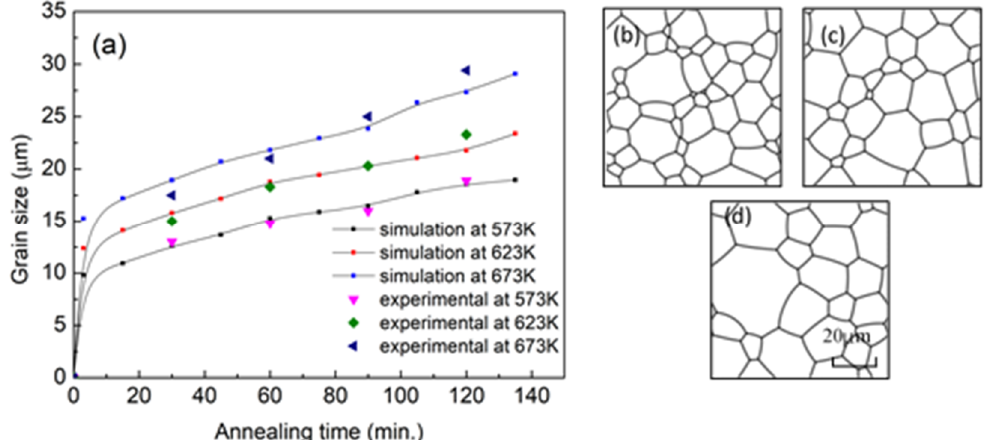
Figure 3. ( a ) The comparison of grain size; ( b ) simulation microstructures at 573 K and 30 min; ( c ) simulation microstructures at 623 K and 30 min, ( d ) simulation microstructures at 673 K and 30 min.